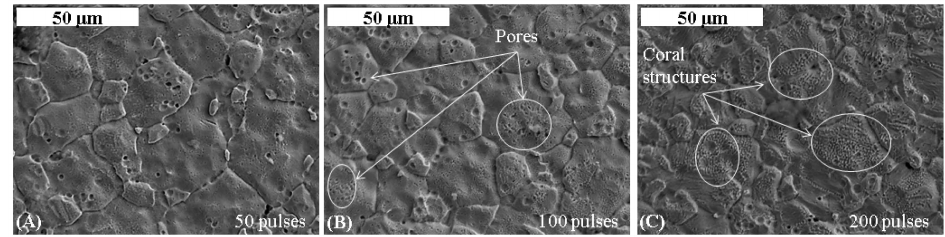
Figure 6. The microstructure of Nimonic 263 after LSP processing by laser energy of 25 mJ and wavelength of 532 nm (power density 2.6 GW/cm 2 ), and number of pulses 50 ( A ); 100 ( B ) and 200 ( C